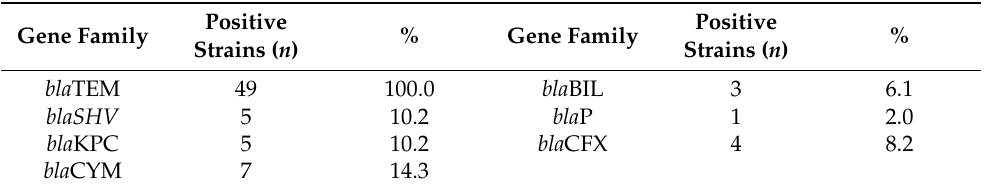
Table 4. Frequency of beta-lactamase gene families identified by endpoint PCR in roads cultured from gut microbiota in healthy conditions.